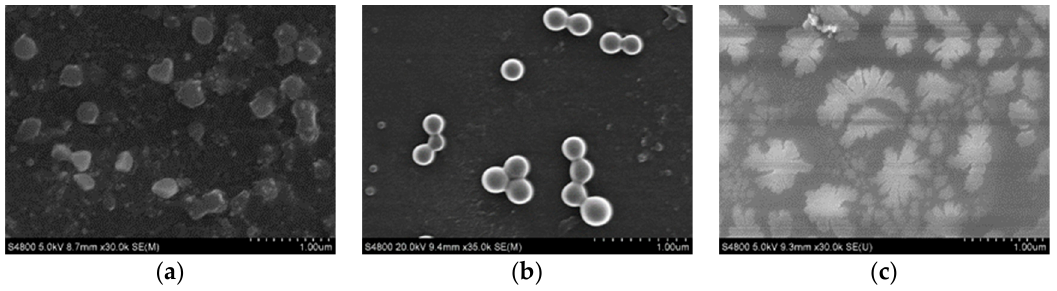
Figure 4. SEM images of SRL nanoparticles prepared at different AS/S ratios: ( a ) AS/S = 10; ( b ) AS/S = 20; ( c ) AS/S = 30.